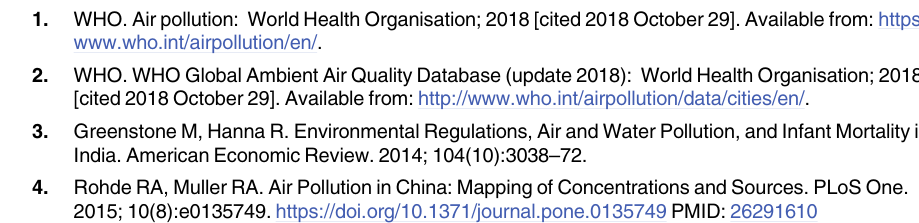
S1 Table. Marginal impacts of average AQI on general obesity and central obesity among older people from the China Health and Retirement Longitudinal Study 2015 (based on Model 2). S2 Table. Regression results (Odds ratio and 95%CI) for testing mediating role of physical activity by further adjusting for physical activity. S3 Table. Regression results (Odds ratio and 95%CI) for associations between air quality measures and physical inactivity among older people from the China Health and Retire- ment Longitudinal Study 2015. S1 Fig. Predicted general obesity (Left) and abdominal obesity (Right) among older adults by disability, the China Health and Retirement Longitudinal Study